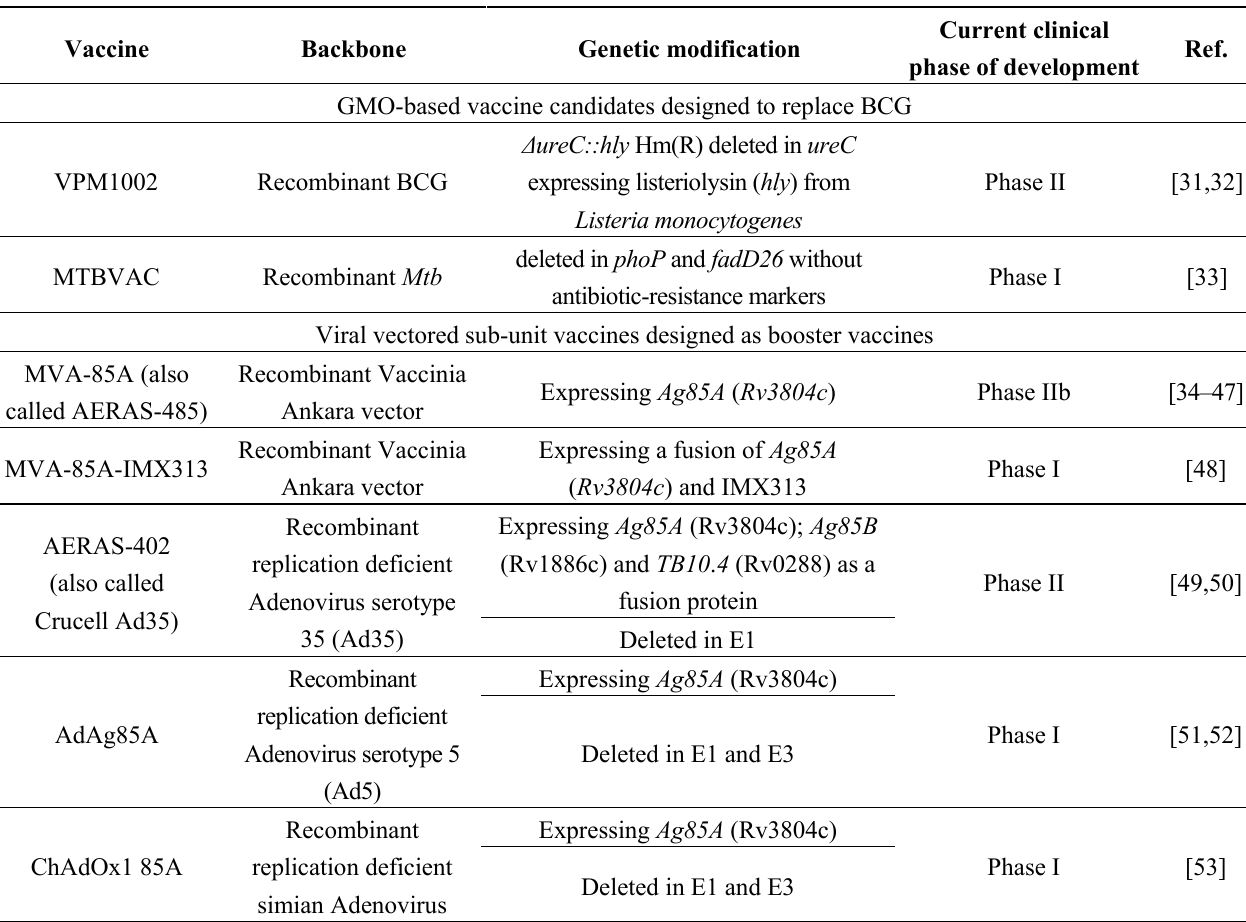
Table 2. GMO-based vaccine candidates against TB in clinical